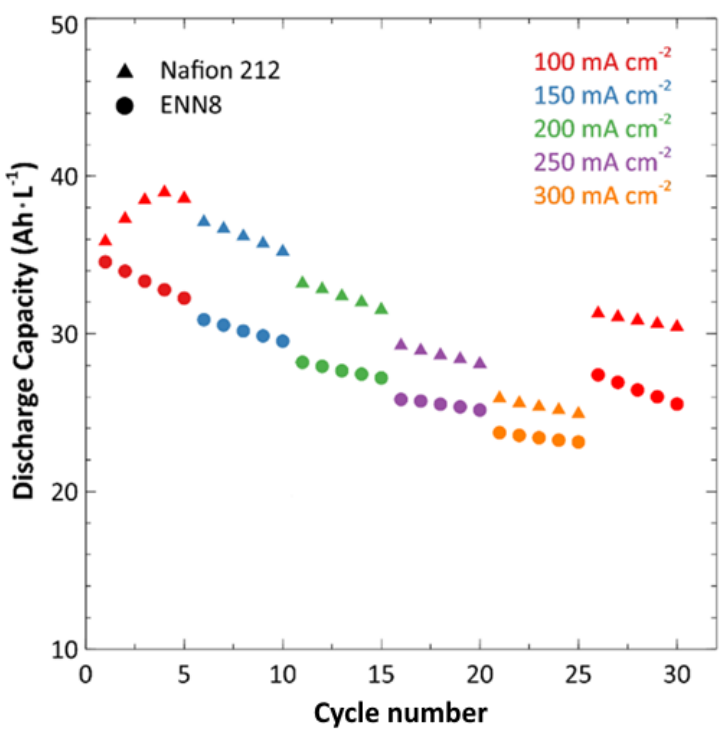
Figure 5. Rate performance test, showing discharge capacity for different current densities.